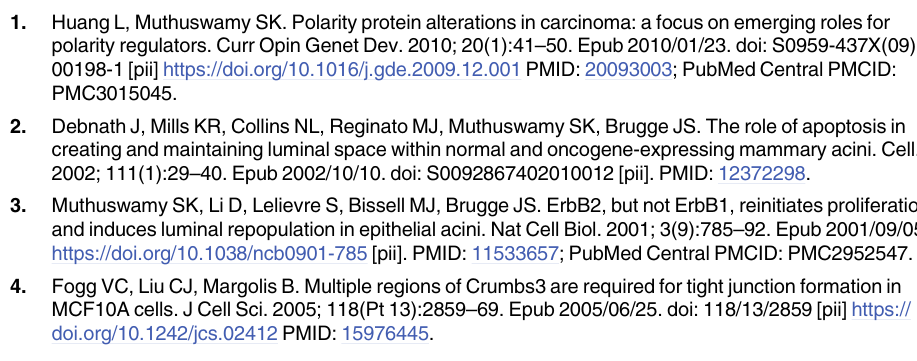
( �� p < 0.01 using Students t test). S4 Fig. Co-expression of an HA-tagged EPB41L4B murine ortholog with CRB3 in MCF- 10A cells. (A) The murine ortholog of EPB41L4B was expressed to equal levels in vector con- trol and CRB3-expressing MCF-10A cells. 50 μ g of total cell lysate was analyzed by immuno- blotting with an HA-epitope antibody, 6E2, (top) and a polyclonal antibody against CRB3 (bottom) with GAPDH as a loading control. (B) Representative phase images of MCF-10A cells expressing CRB3 alone or co-expressing CRB3 and EPB41L4B. Scale bars, 50 μ m. (EPS) S1 File. Primary data from siRNA screen of FERM proteins. Genes with an annotated FERM domain were analyzed for reduced AREG secretion in CRB3-expressing MCF-10A cells using the AREG ELISA. Data are the calculated AREG amounts in pg/mL. Data are repre- sentative of n = 3